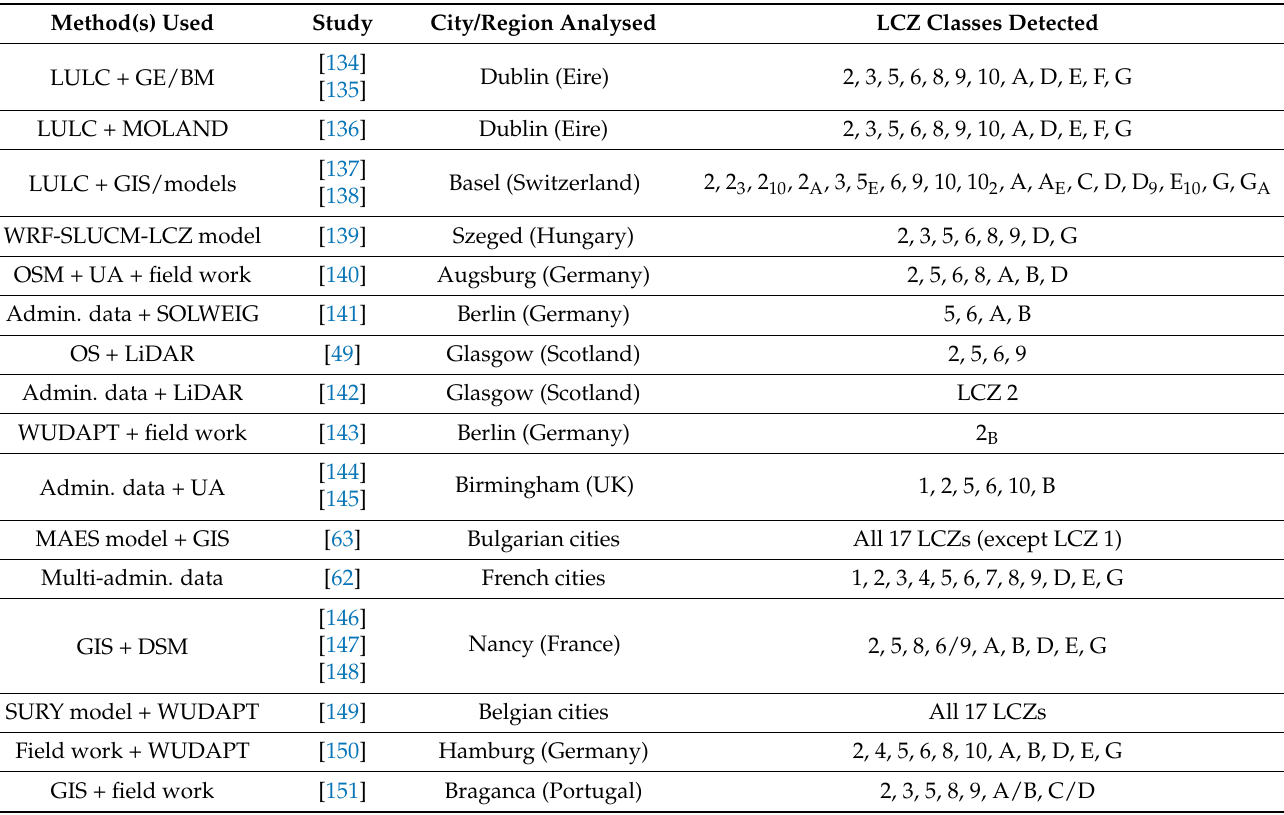
Table 4. Combined methods for LCZ mapping derived from studies identified in this